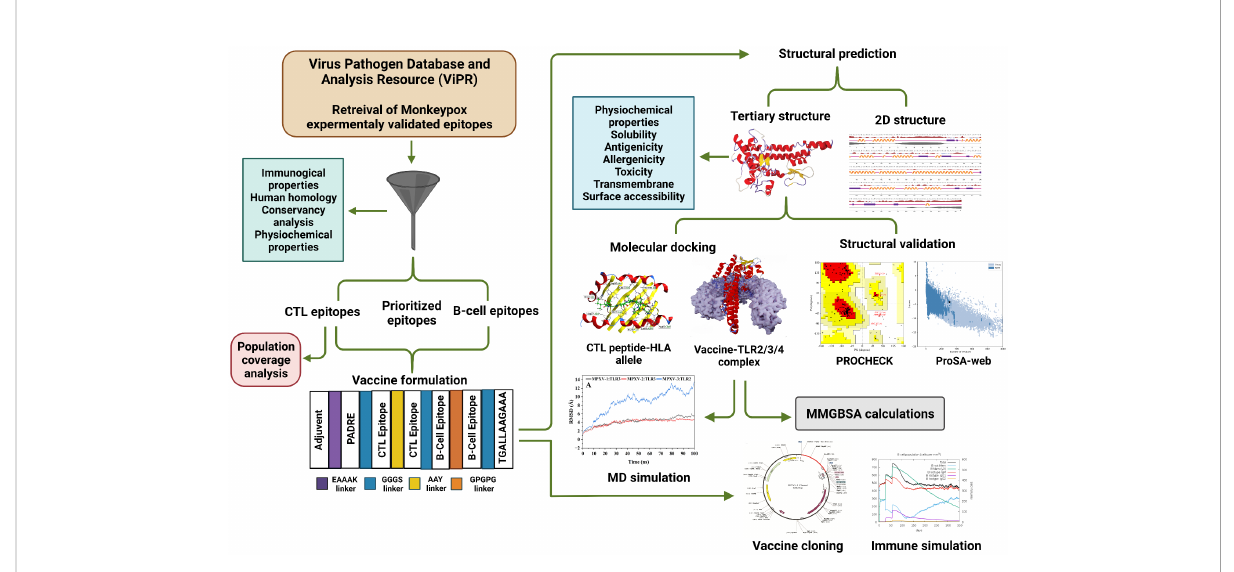
FIGURE 1 Overall work fl ow to design vaccine candidates for monkeypox in this